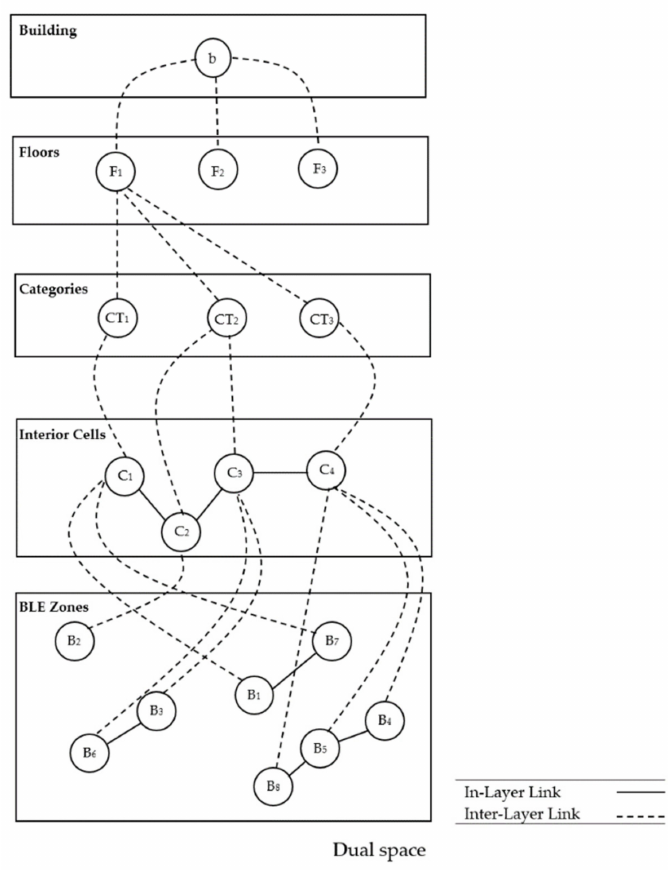
Figure 6. An example of hierarchical structure considered for spatial